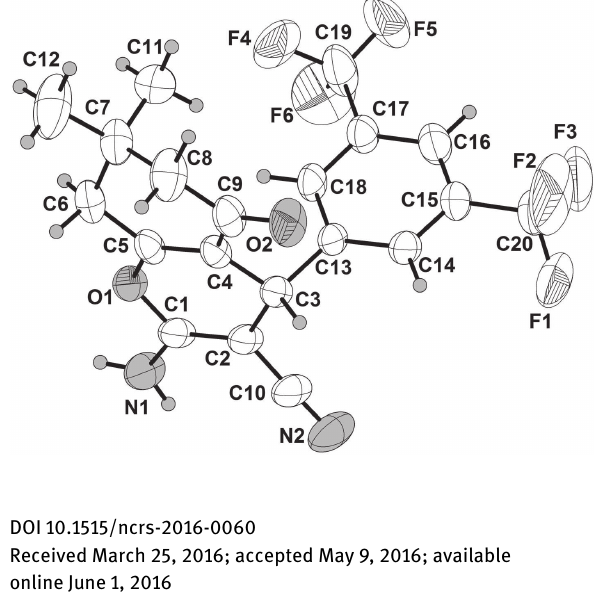
Table 1: Data collection and handling.